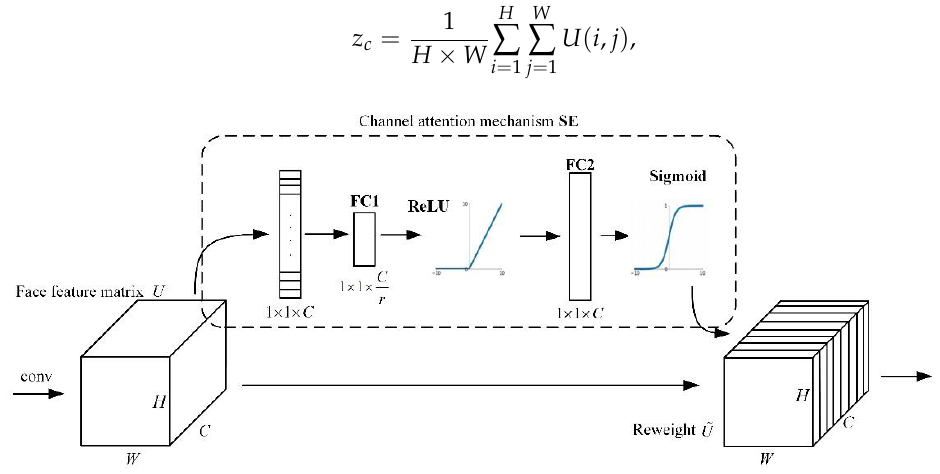
Figure 3. Channel attention mechanism SE module.